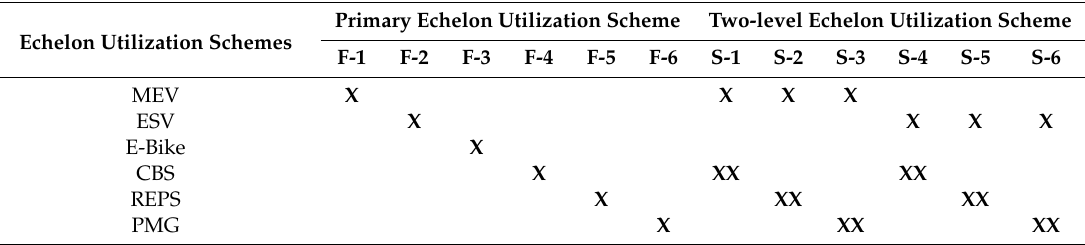
Table 3. Echelon utilization schemes of retired power battery.